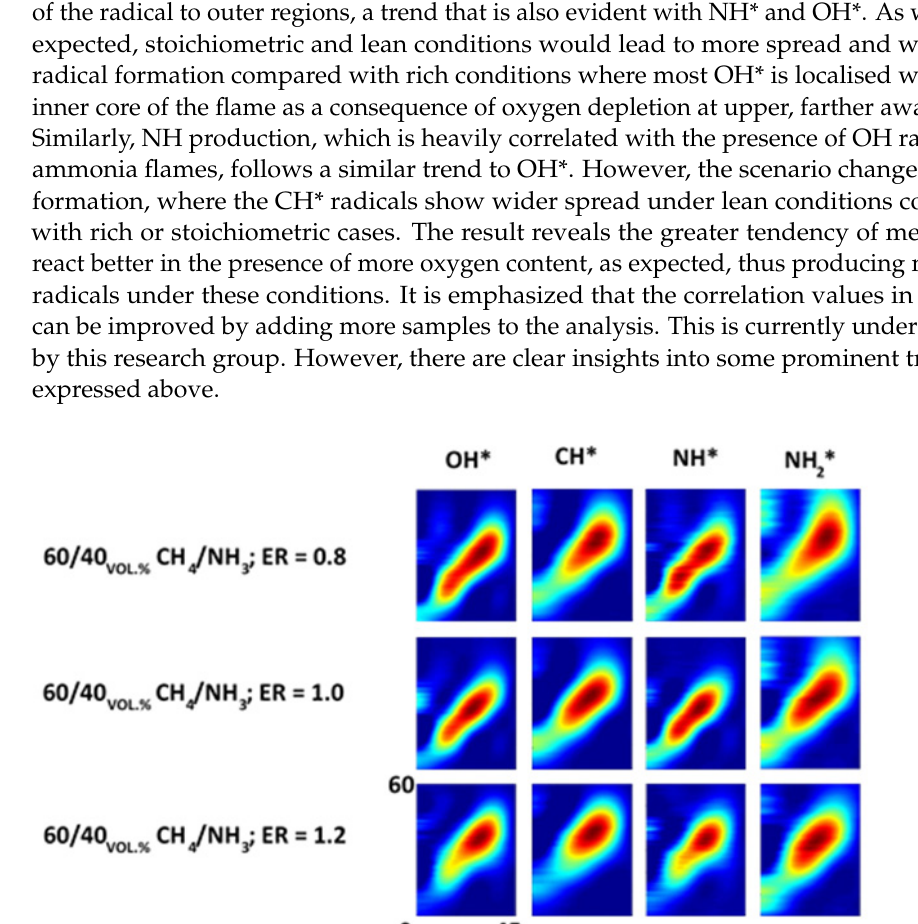
Figure 4. Emission results. ( a ) CO (ppm); ( b ) CO2 (%); ( c ) NH3 (ppm).